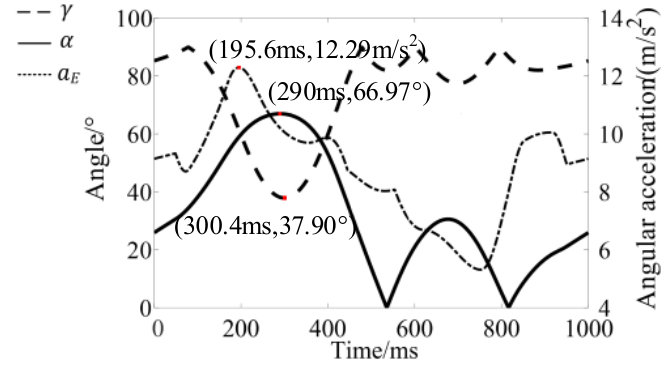
Figure 13. Motion characteristics before optimization.